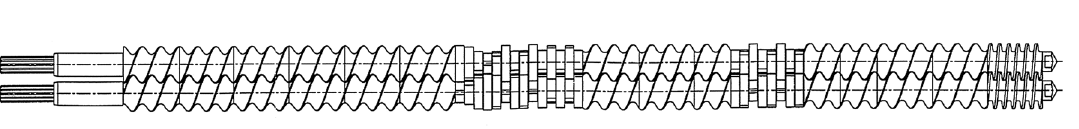
Figure 1. Synthesis scheme of MMA-MA copolymer.